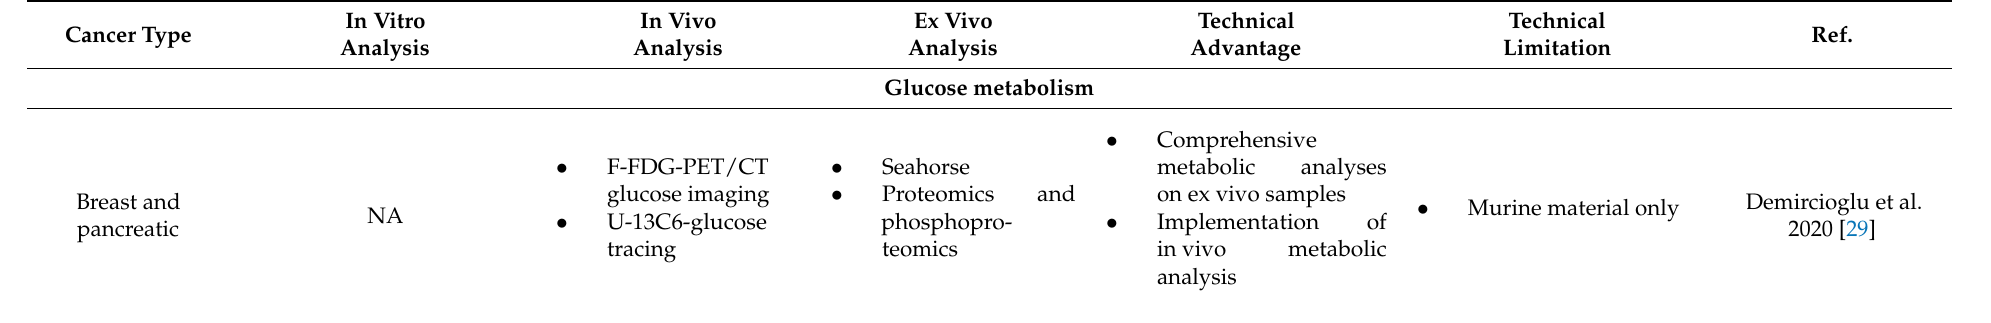
Table 1. Summary of the CAF-tumor cell crosstalk metabolic studies. Abbreviations: Glucose (Glc), Glutamine (Gln), NA, Not